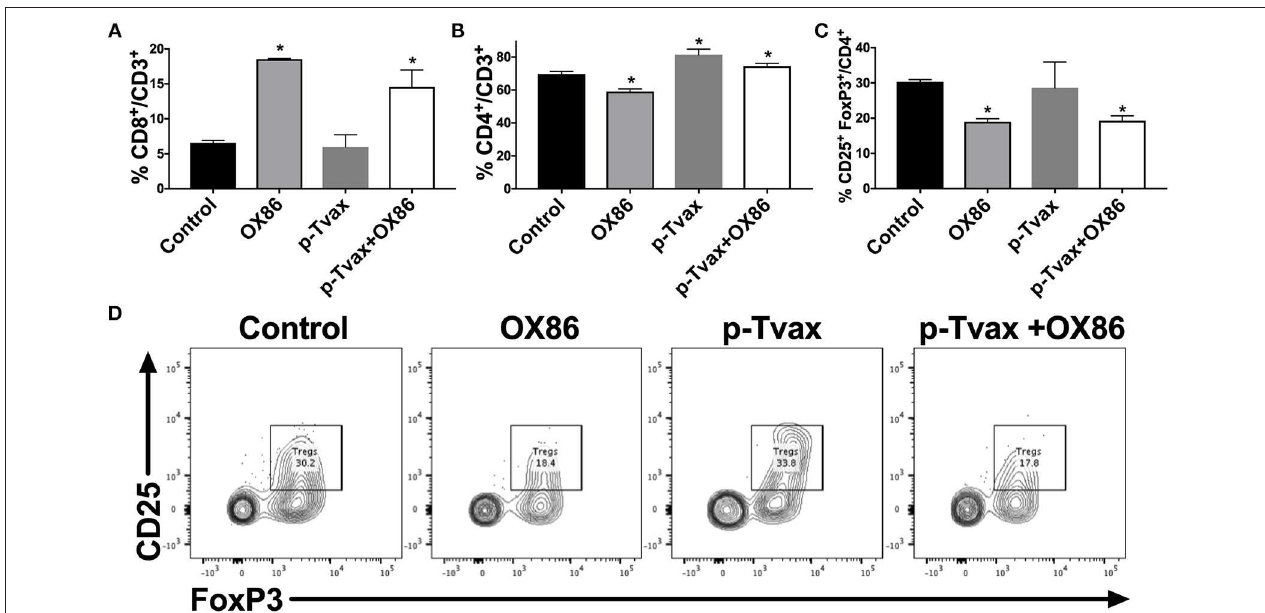
FIGURE 5 | p-Tvax in combination with OX40 agonists induce CD8 + and CD4 + T cell tumor infiltration while reducing T regulatory cells. CRH5 tumors from controls or from mice treated with p-Tvax, OX86 mAbs, or with a combination of the two, were collected and enzyme-digested. Staining was performed using anti-mouse CD3, CD8, CD4, CD25, and FoxP3 antibodies with live cells distinguished from debris using LIVE/DEAD ® cell viability dye. (A) Percentage of CD8 + T cells in CRH5 tumors from treated and control mice. Results represent mean ± S.E. with means of each group compared using ANOVA followed by Bonferroni test (* p < 0.05, n = 5, vs. Control). Data for CD4 + T cells and Tregs cells are showed, respectively in (B,C) . (D) Representative data from flow cytometric analysis of CRH5 tumors in treated and control mice using CD25 and FoxP3 markers for Tregs, including Tregs that were previously gated in the CD3 vs. CD4 dot